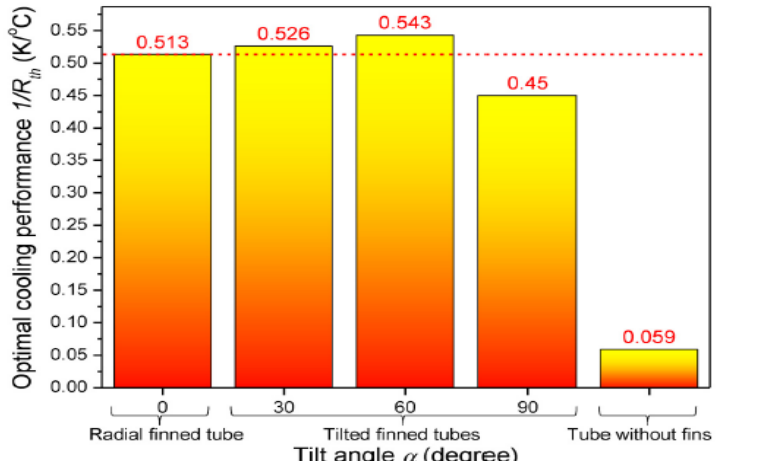
Figure 12: Comparison of the optimal cooling performances